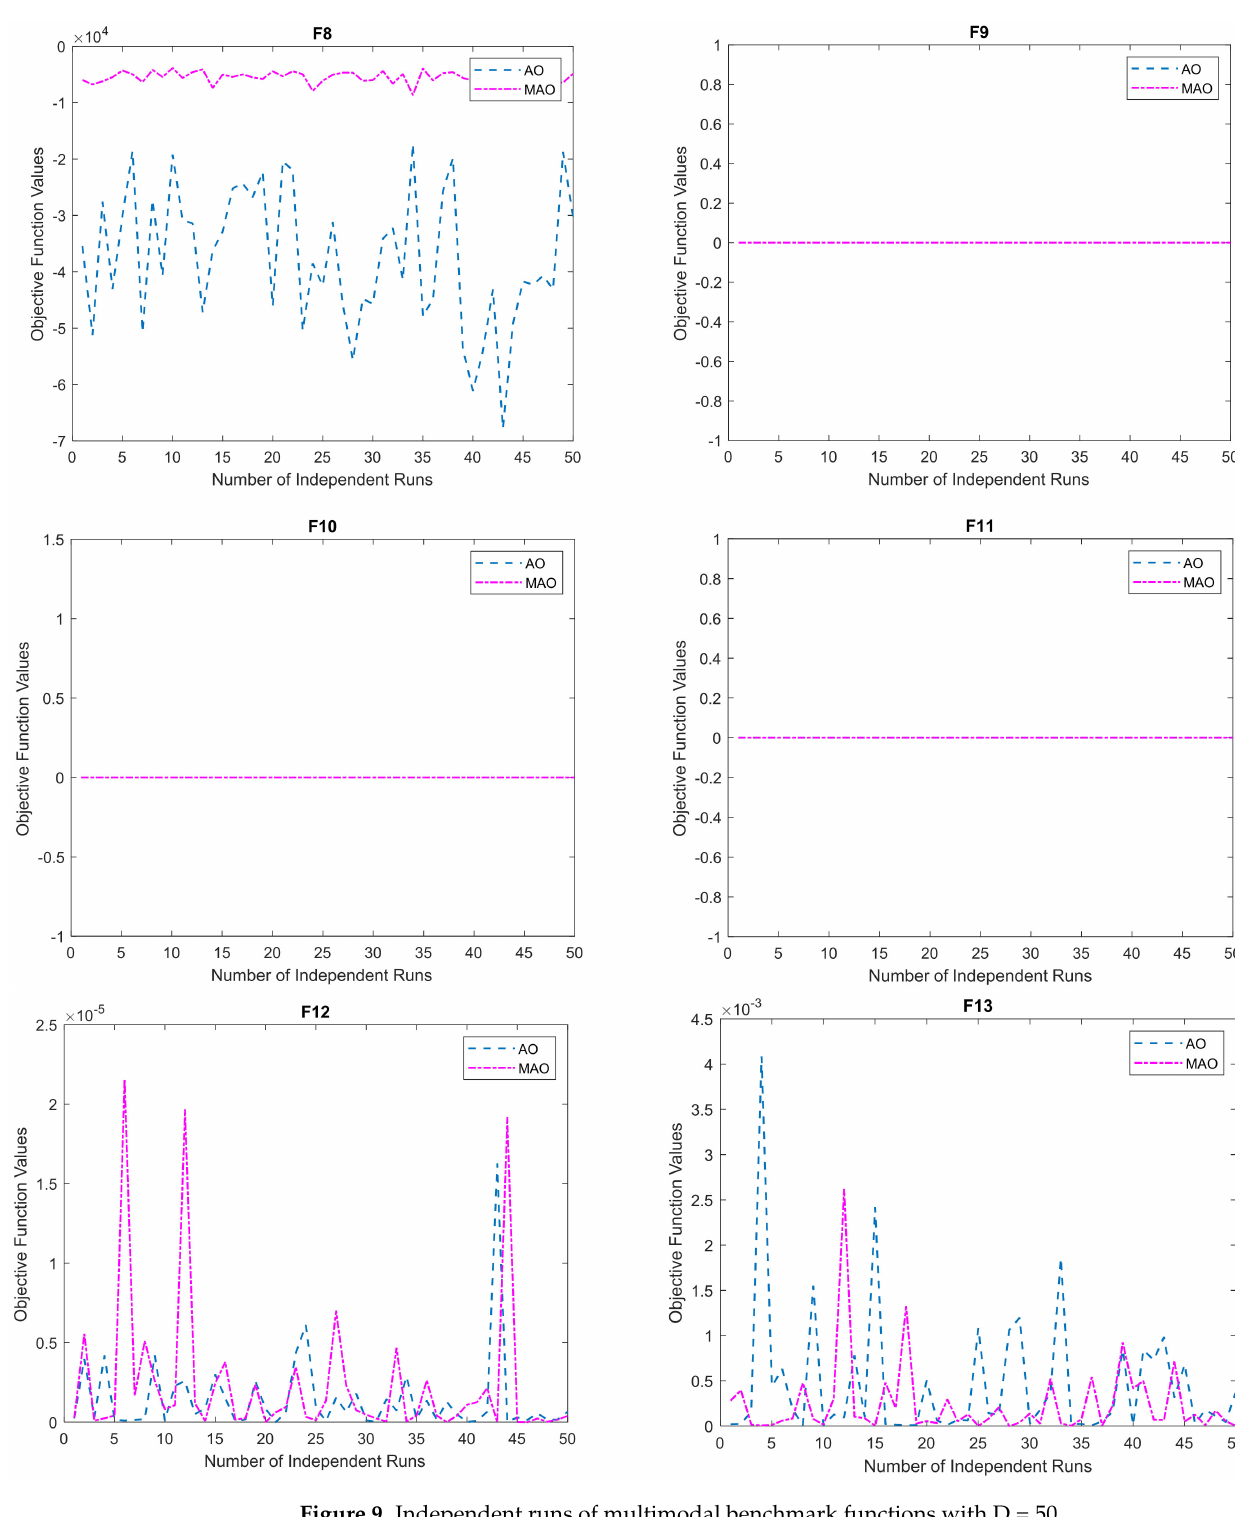
Figure 9. Independent runs of multimodal benchmark functions with D =